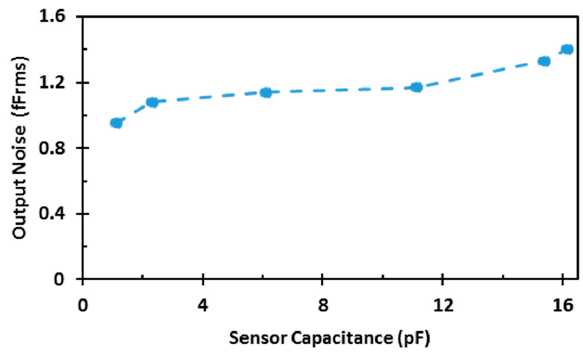
Figure 9. Measured noise output as a function of capacitance.